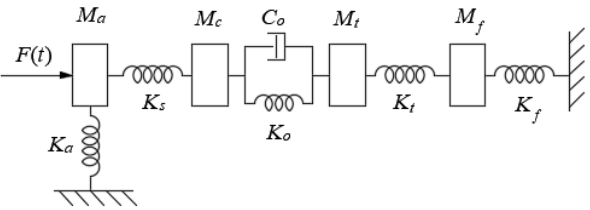
Figure 9. Mathematical model of test rig without control from friction damper. Table 1. Parameters used in the mathematical model. Parameter Symbol Shafting mass